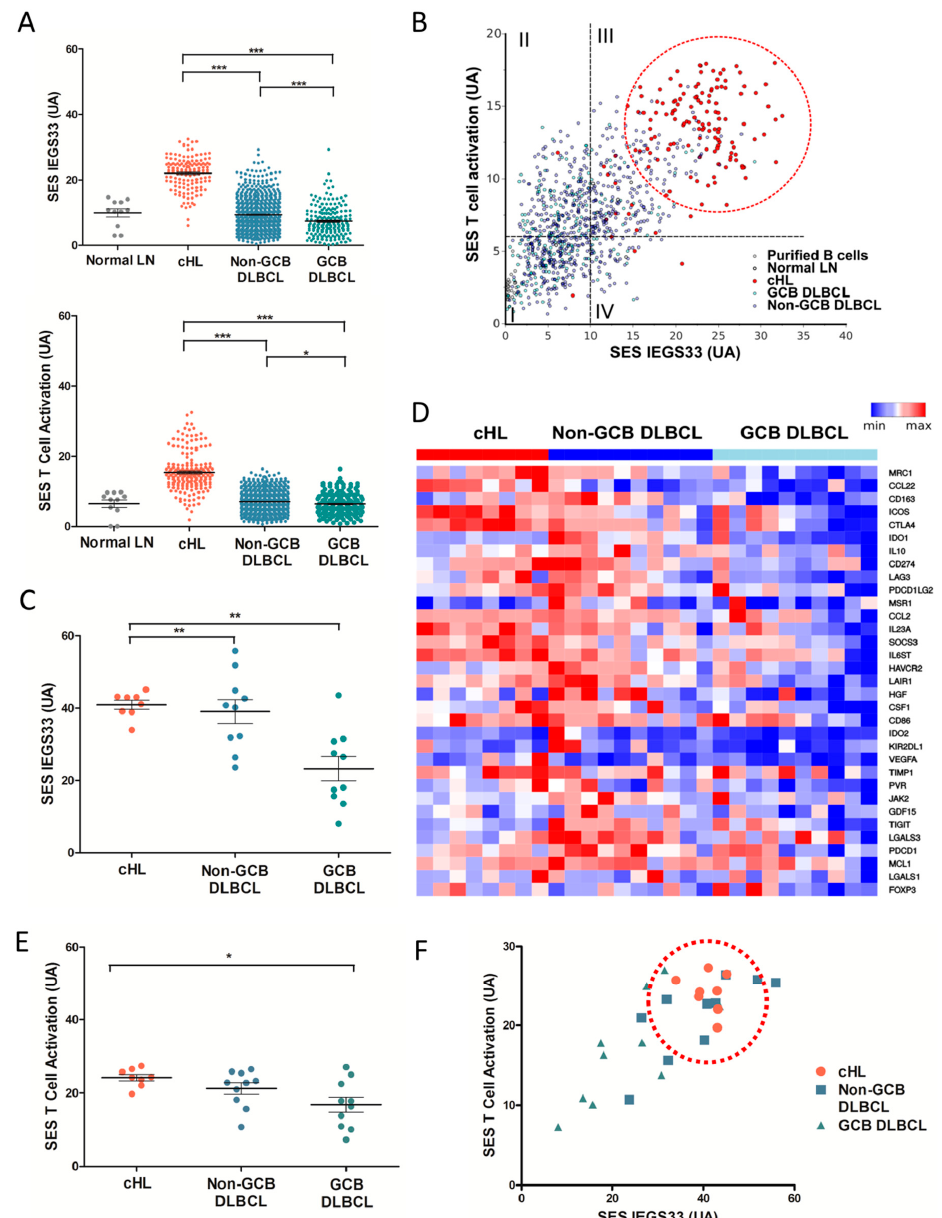
Figure 1. Molecular profiling of immune escape pathways in classical Hodgkin’s lymphoma and in diffuse large B-cell lymphoma. ( A ) Sample enrichment score (SES) for immune escape gene set IEGS33 (top) and for the T-cell activation gene set (bottom) in cHL, non-GCB DLBCL, GCB DLBCL, and reactive lymph node samples from public microarrays datamining analysis ( n = 1061). ( B ) SES dot plots for IEGS33 versus T-cell activation for cHL, non-GCB DLBCL, GCB DLBCL, normal B-cell, and reactive lymph node samples from public microarrays datamining analysis ( n = 1106), showing clustering of cHL samples at stage 3 of cancer IE (red circle), according to the 4 cancer IE stages, as previously defined [25] (cancer IE stage 1 (IEGS33 − T-cell activation − ), cancer IE stage 2 (IEGS33 − T-cell activation + ), cancer IE stage 3 (IEGS33 + T-cell activation + ), cancer IE stage 4 (IEGS33 + T-cell activation − ). ( C ) SES for IEGS33 in cHL, non-GCB DLBCL and GCB DLBCL samples from our private cohort ( n = 28). ( D ) Heatmap of differential IE gene expression for cHL and DLBCL samples from our private cohort ( n = 28). ( E ) SES for the T-cell activation gene set in cHL, non-GCB DLBCL, and GCB DLBCL samples from our private cohort ( n = 28). ( F ) SES dot plots for IEGS33 versus T-cell activation for cHL, non-GCB DLBCL, GCB DLBCL samples from our private cohort ( n = 28), showing clustering of cHL samples in stage 3 (red circle). (* p < 0.05, ** p ≤ 0.01, *** p ≤